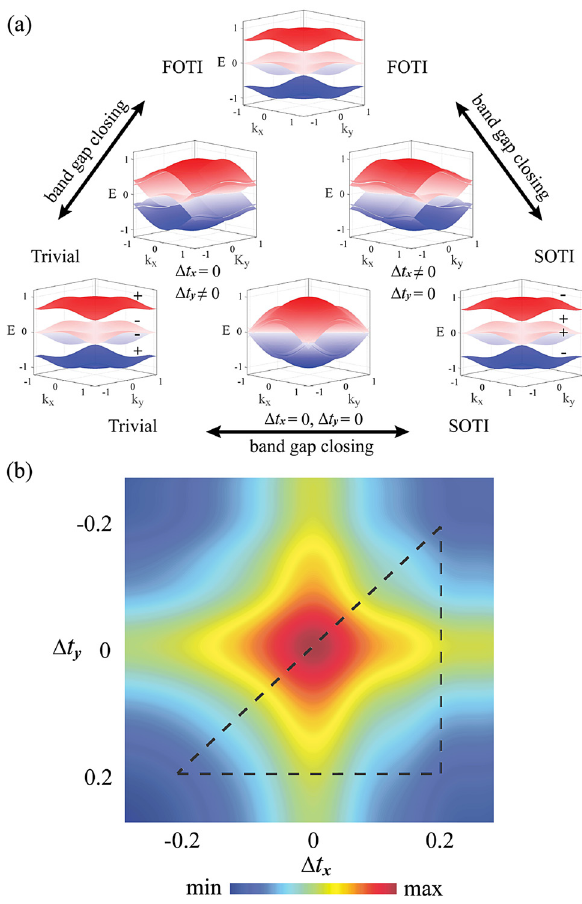
Figure 2: Topological phase transition and its indicator. (a) The band structures in topological phase transition. The arrows indicate the phase transition among trivial, FOTI and SOTI phases. (b) The simulated results of TPTI as a function of Δ t shows the phase transition trajectories detected in